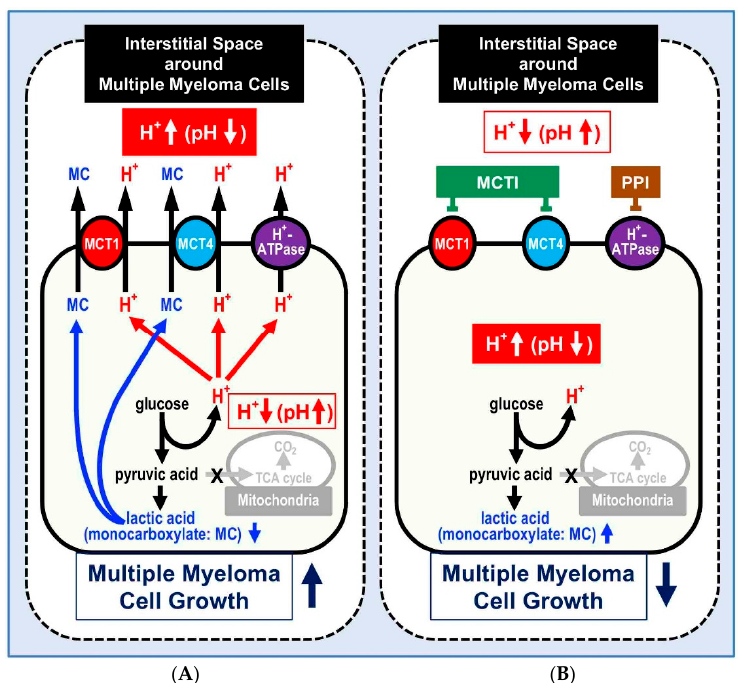
Figure 2. Production and transporting systems of H + and lactic acid without ( A ) and with ( B ) inhibitors of proton pumps and/or MCT in multiple myeloma (MM) and diabetic mellitus cells with mitochondrial dysfunction under normoxemic or hypoxemic conditions. ( A ) Production and transporting systems of H + and CO 2 in normal cells with normal mitochondrial function under normoxemic conditions. H + is extruded by H + -ATPase and MCT. Lactic acid is extruded by MCTs coupled with H + . ( B ) Production and transporting systems of H + and CO 2 in multiple myeloma (MM) and diabetic mellitus cells with mitochondrial dysfunction under normoxemic or hypoxemic conditions. MCT, Mono-Carboxylate Transporter: MCTI, Mono-Carboxylate Transporter Inhibitor: PPI, Proton Pump